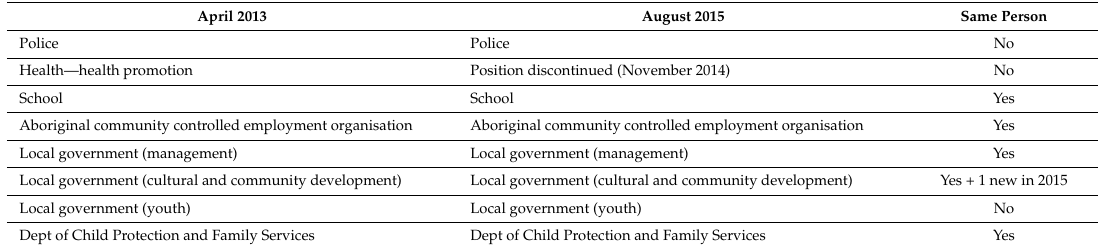
Table 1. Agencies contributing to HCAT assessment